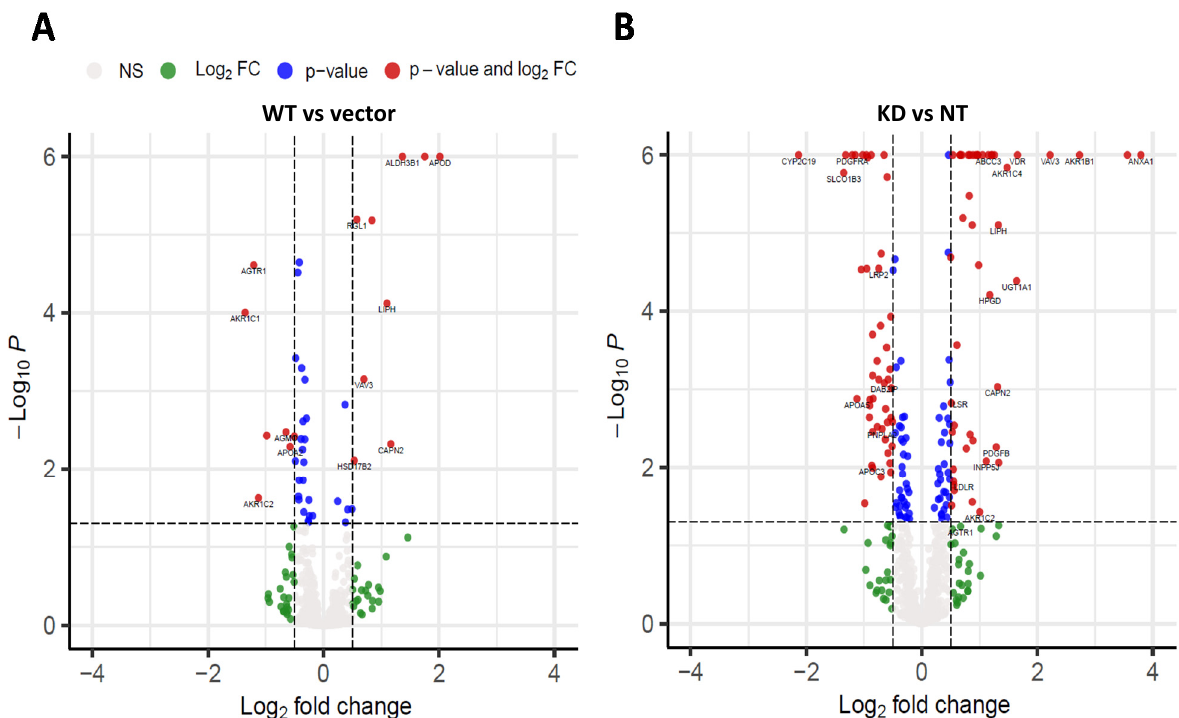
Figure 4. Changes in expression of lipid metabolizing genes in response to TM6SF2 overexpression or knockout. Volcano plots shows relative abundance of lipid metabolizing genes identified through RNA Sequencing. X -axis is the log 2 fold change of gene expression in Huh-7 cells for ( A ) wild-type overexpression compared to vector control ( B ) TM6SF2 knockdown compared to non-targeting control. For both ( A , B ), Y -axis represents the adjusted p value. Negative values indicate downregulated genes while positive values indicate upregulated genes in the overexpression or knockdown cells compared to their respective controls. Vertical dotted lines represent the threshold for log 2 fold change (>0.5 or < − 0.5) and horizontal dotted line represent the threshold for adjusted p value (Benjamini–Hochberg correction for multiple testing ; p < 0.05). Genes belonging to the lipase or the AKR1 family of genes that met the threshold criteria for both p -value and log fold change are labelled (red dots). Detailed information on the names, fold change and significance of genes meeting both threshold are shown in Supplementary Table S2. Wild-type TM6SF2 (WT), pCMV empty vector control (Vector), non-targeted shRNA control (NT), and TM6SF2 knockdown (KD).